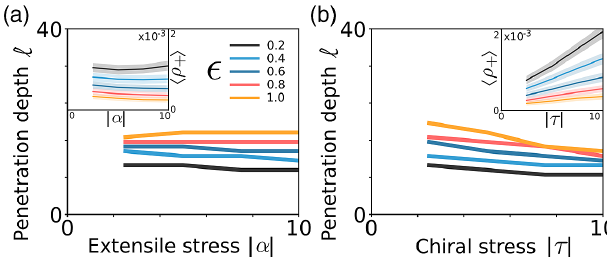
FIG. 5. Penetration depth l of the chiral edge currents versus magnitude of active stresses. (a) Extensile stress α ( τ ¼ − 5 ) and (b) chiral stress τ ( α ¼ − 10 ). Insets: the average density h ρ þ i of þ 1 = 2 defects versus the active